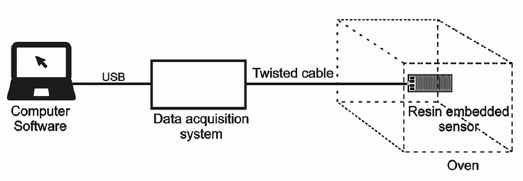
Figure 3. Schematic representation of the assembly for DEA.